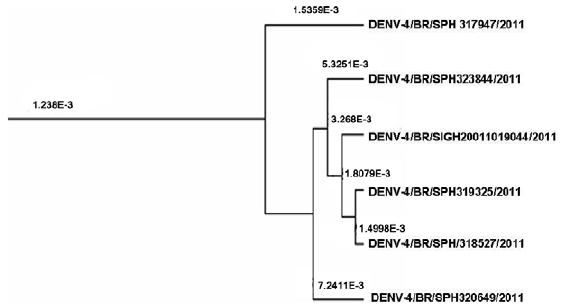
Figure 2. Detail of the Envelope gene MCC tree. Bolded numbers above branchs are the estimated replacement rates for each sample. The acceleration observed in this terminal branch ma be indicative of a recent introduction of the virus in a previously naı¨ve